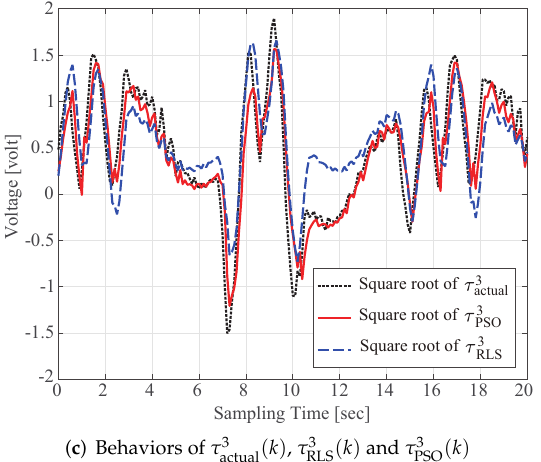
Figure 7. Comparison of the measured actual torque τ actual , the torque τ i based identification, and the torque τ i in